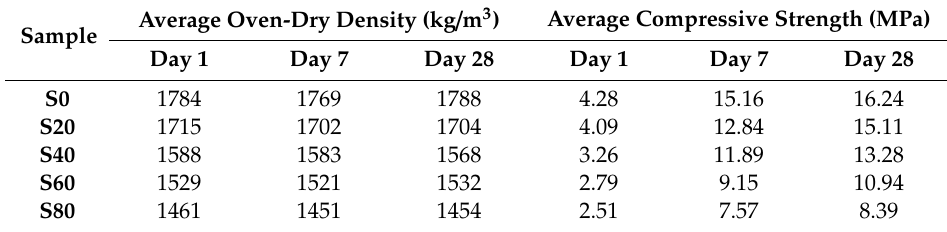
Table 3. Average compressive strength of air-entrained rubberized concrete with di ff erent mix proportions on day-1, day-7 and